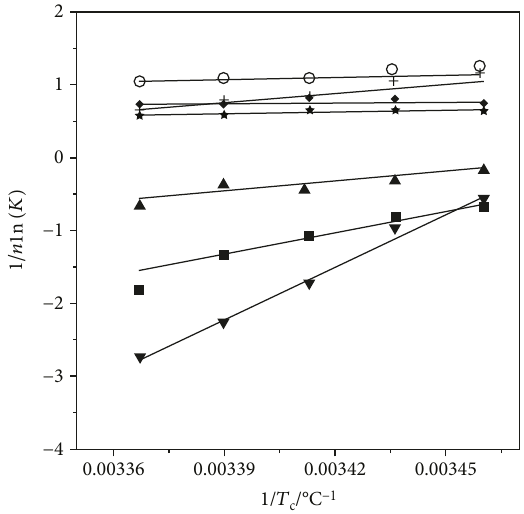
Figure 10: Arrhenius plots 1/ n ln K vs. 1/ T homopolymer and SCL# and HEMACL# copolymers. Symbols: ( ○ ) linear PCL, ( + ) SCL4, ( ♦ ) SCL3, ( ★ ) SCL1, ( ▲ ) HEMACL1, ( ■ ) HEMACL2, and ( ▼ ) HEMACL3.